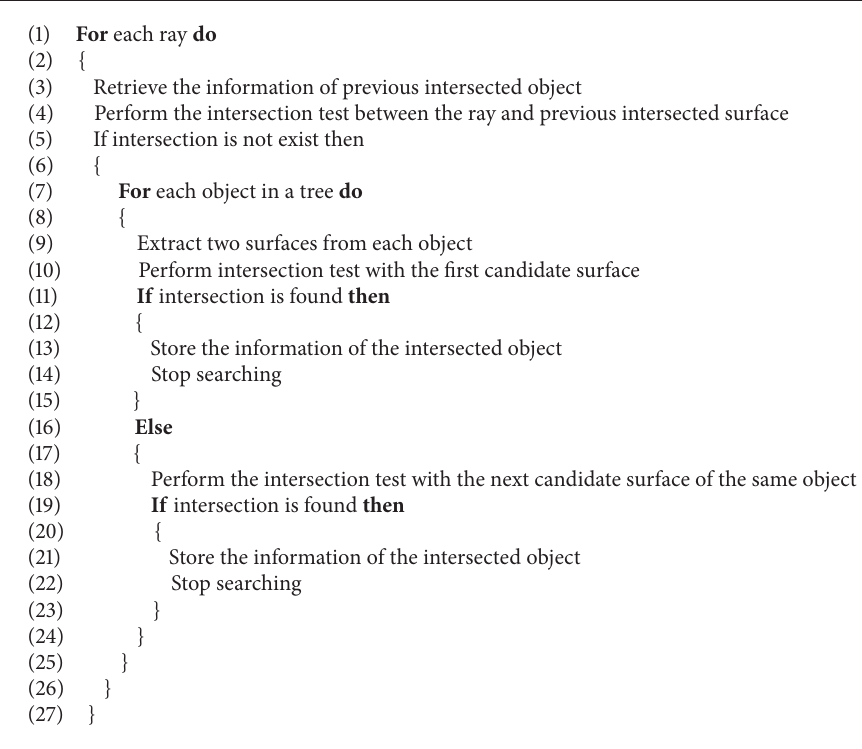
Algorithm 1: Minimization of Ray Object